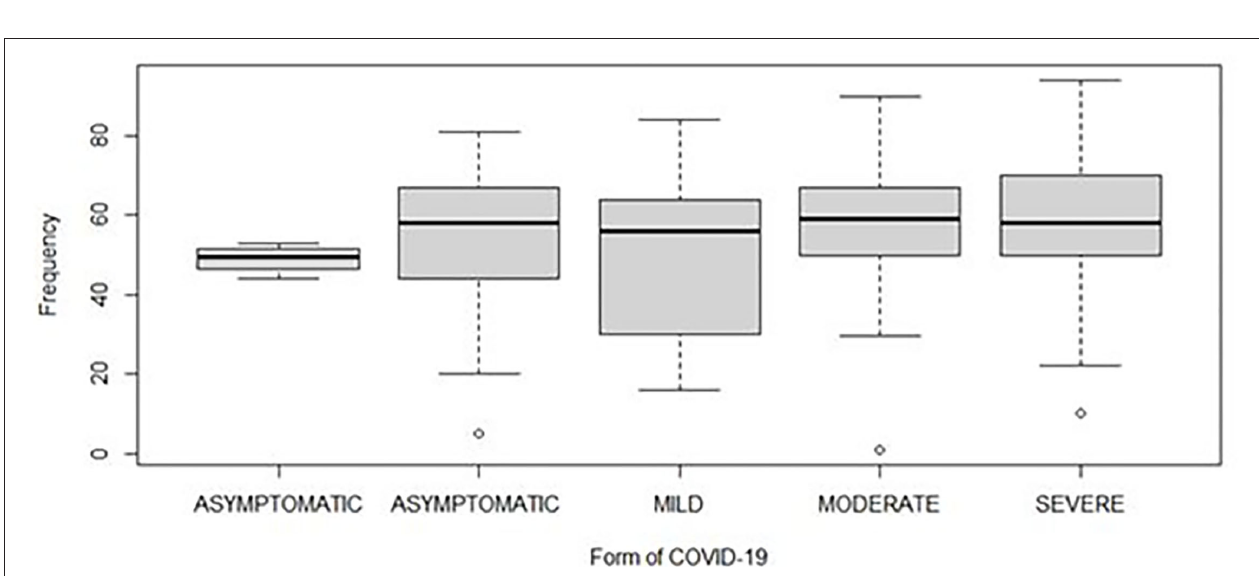
FIGURE 2 | Distribution of the age of patients according to different severities of COVID-19. The horizontal line inside each box represents the median value of the age with interquartile ranges. The dots represent